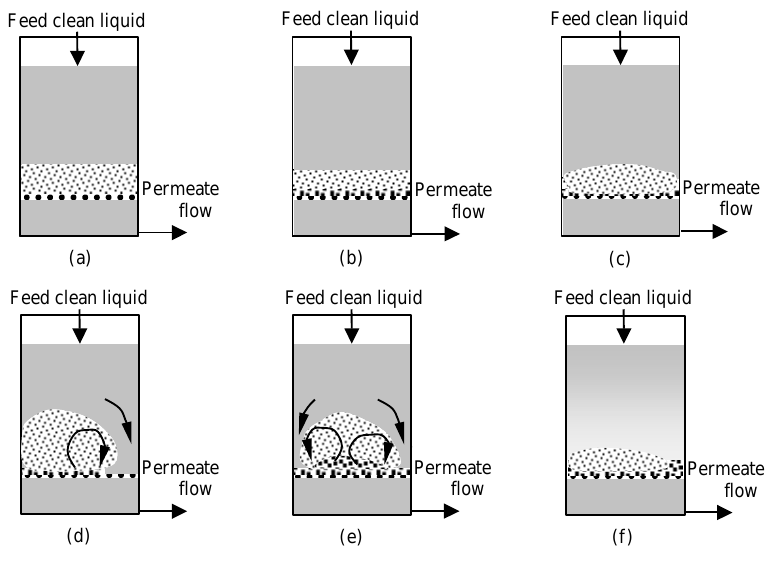
Fig. 13 State of the cake and particles during vibration permeation through a formed cake: the effect of increasing